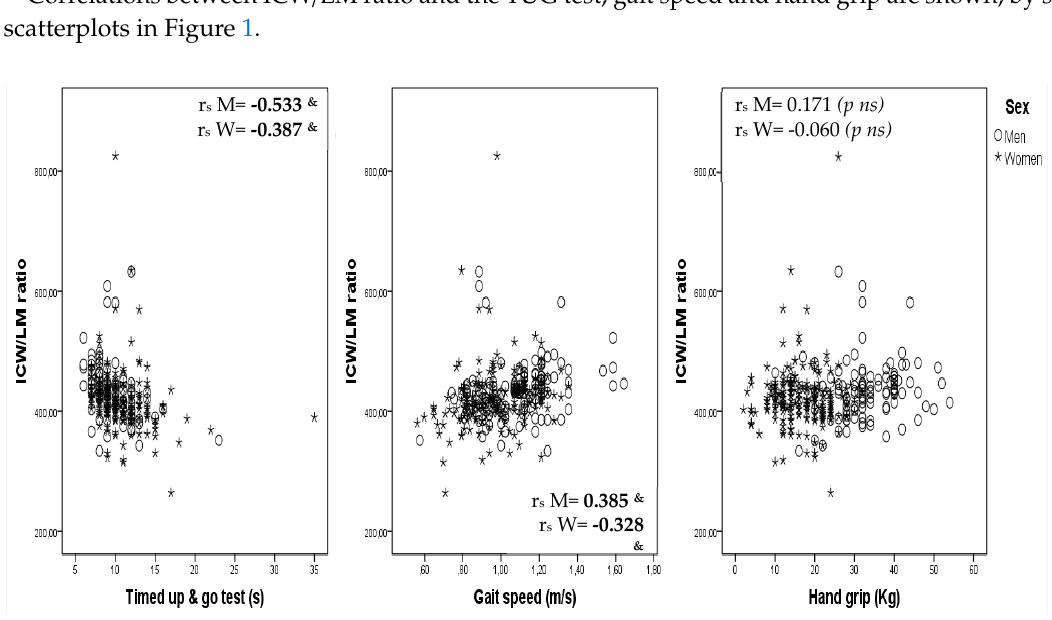
Figure 1. Correlations of intracellular water/lean mass (ICW/LM) ratio and timed up-and-go test, gait speed and hand grip, by sex. rs M: Spearman correlation in men. rs W: Spearman correlation in women ( p < 0.001).